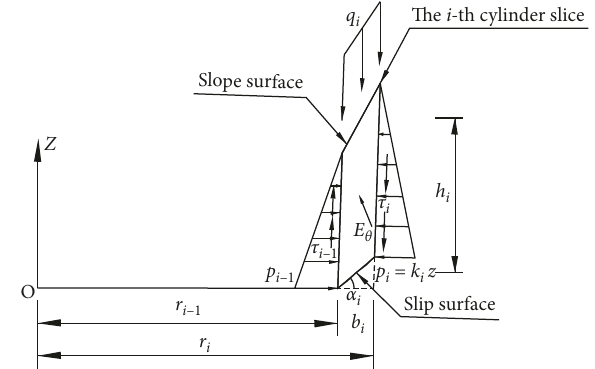
Figure 3: Cross-sectional profile of the i -th cylinder